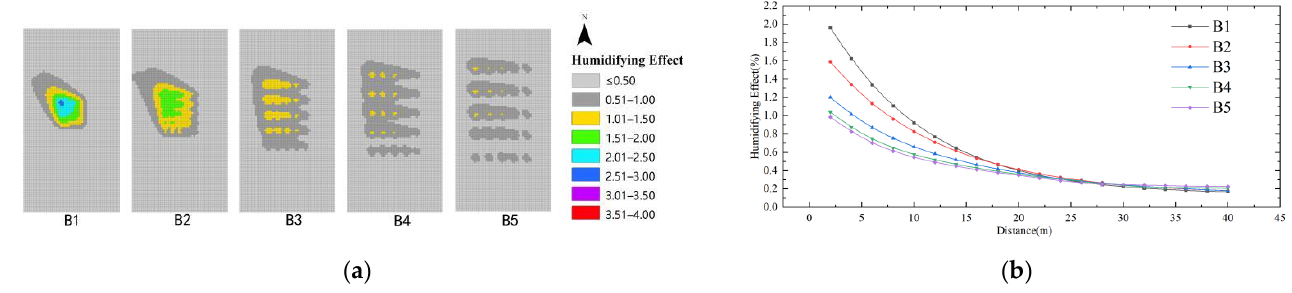
Figure 16. Humidifying effect of water body dispersion index: ( a ) Impact distribution map; ( b ) Im- pacts with distance.